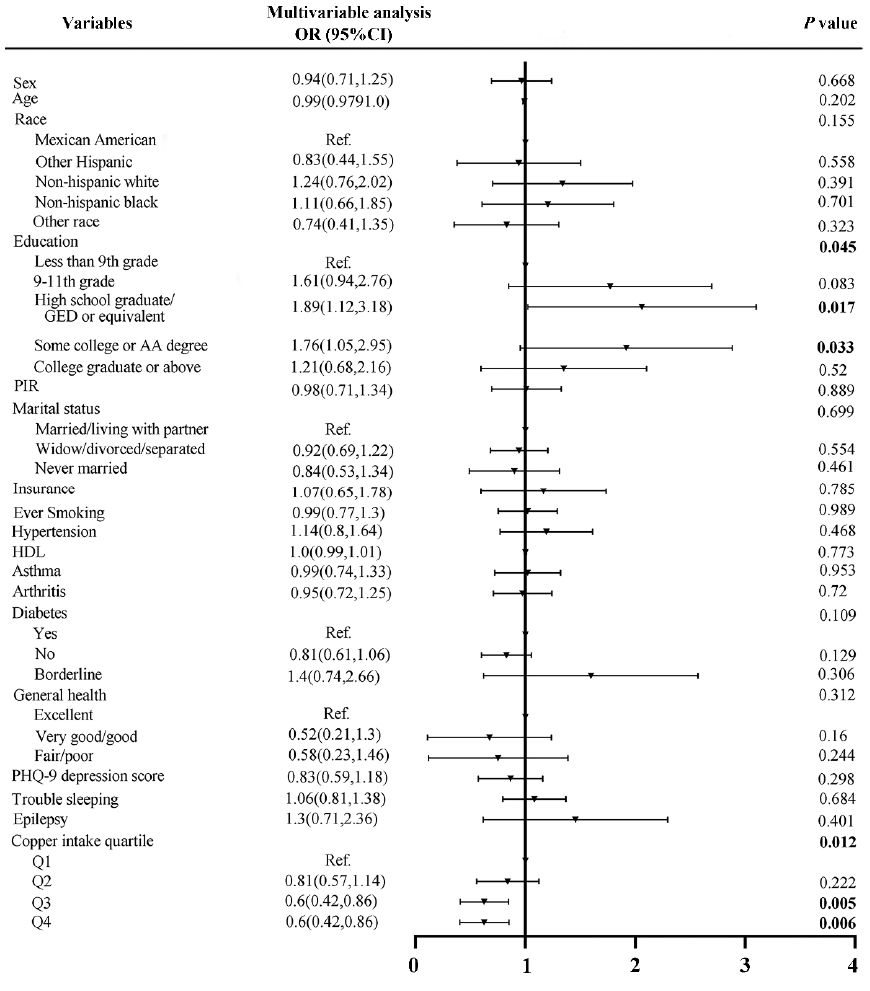
Figure 4. Forest plot of stroke risk factors after matching.